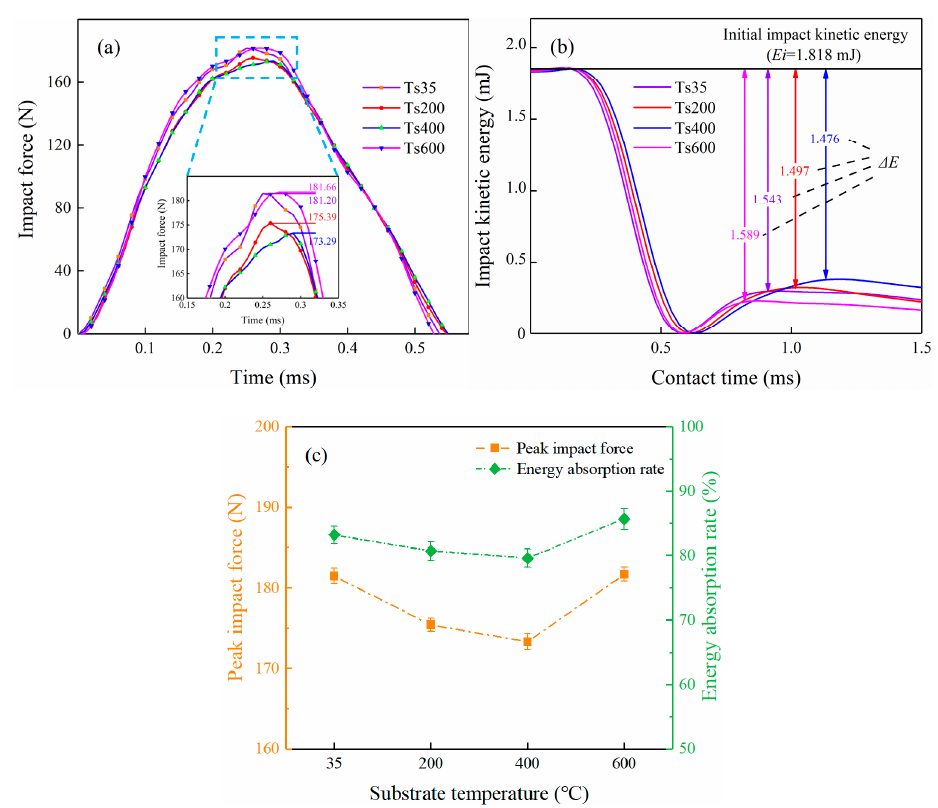
Figure 3. Impact response of TiN coatings prepared under different substrate temperatures: ( a ) Impact force; ( b ) impact kinetic energy; ( c ) peak impact force, and energy absorption rate.